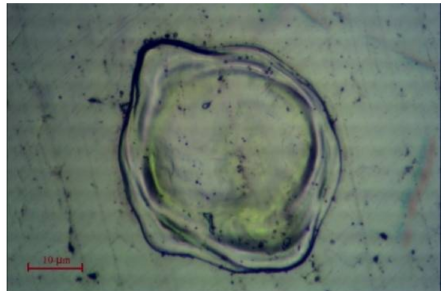
Figure 3. Picture of the discharge crater (Open-circuit voltage U = 110 V and capacitance C = 1000 pF).